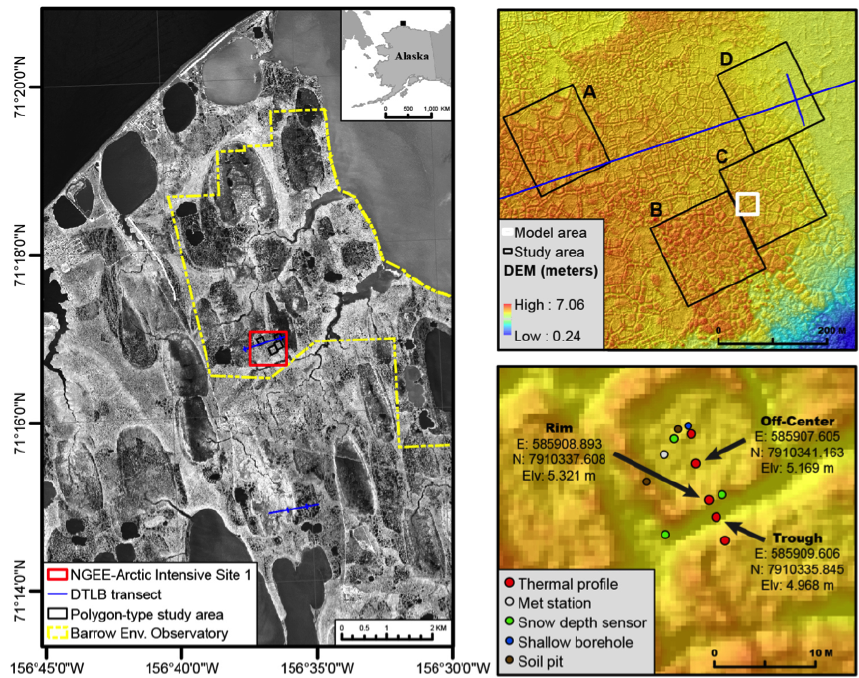
Figure 1. Lidar of site-C with the three observation locations mapped and the greater Barrow, AK, area (credit Garrett Altmann).